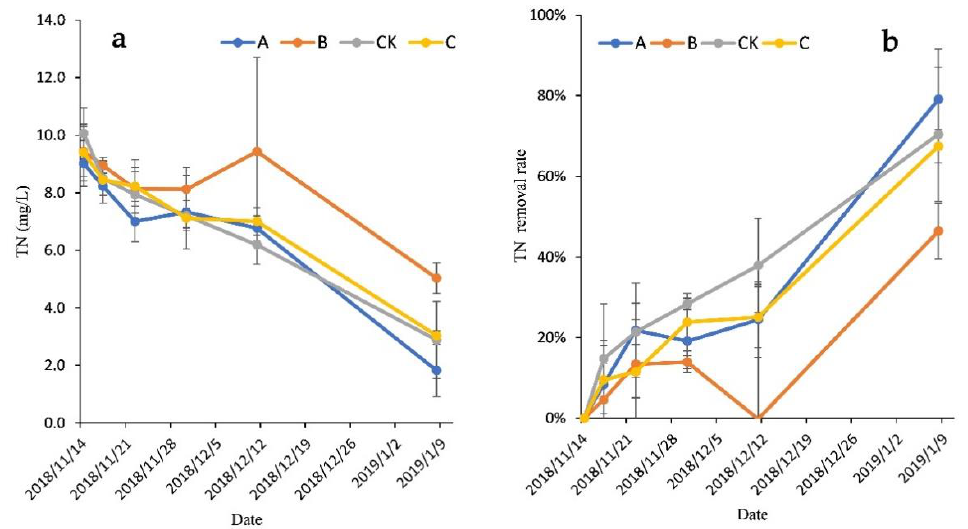
Figure 2. Variation in the ( a ) TN concentration and ( b ) removal rate of each treatment.